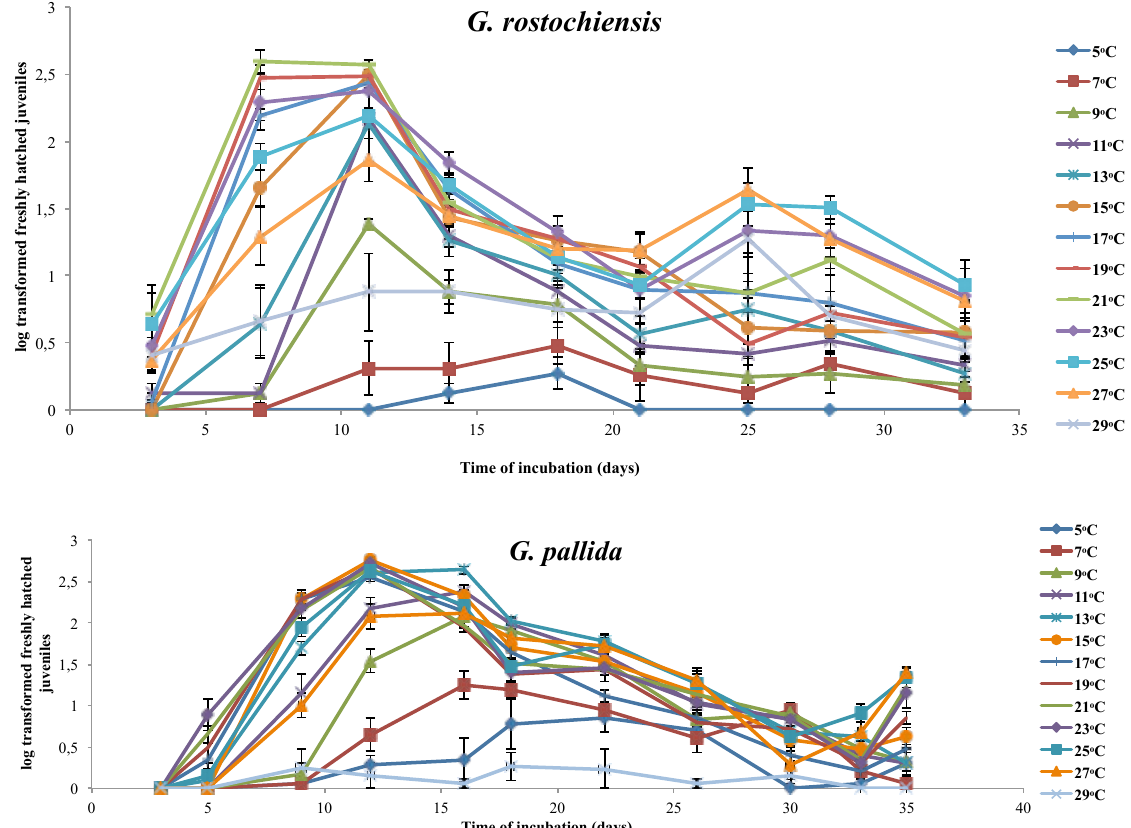
Figure 3. Mean numbers of freshly hatched juveniles of Globodera rostochiensis (a) and G. pallida (b) in potato root diffusate over 35 days of incubation over a temperature gradient from 5–29ºC. Data has been log transformed. Vertical lines indicate standard errors of